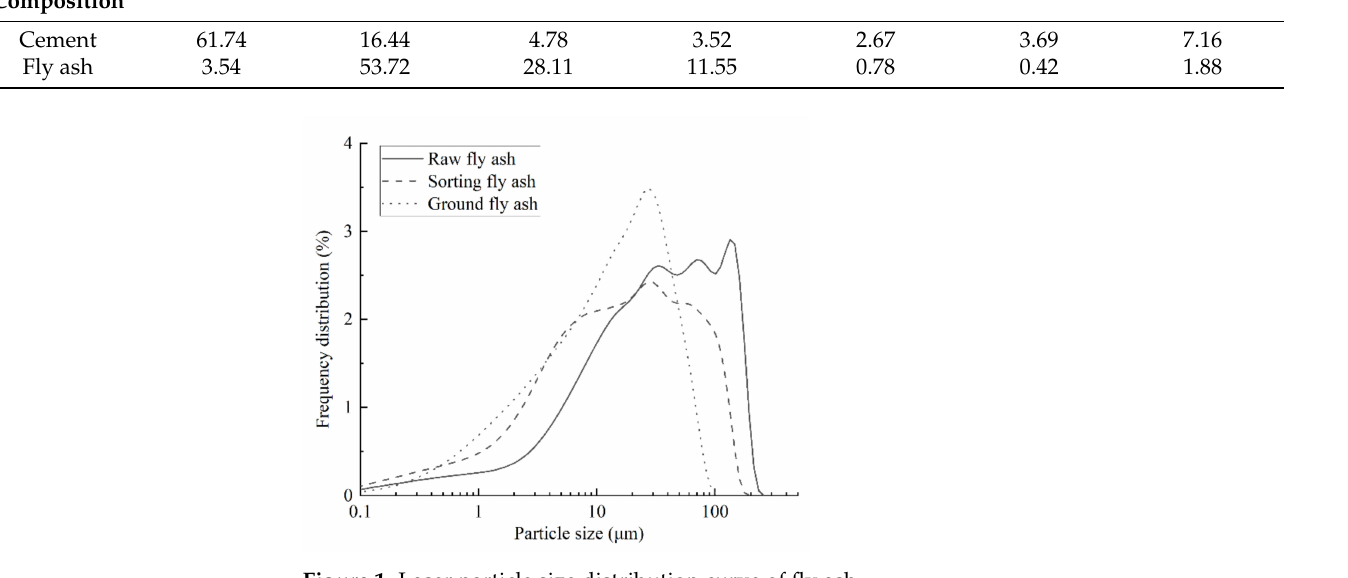
Figure 1. Laser particle size distribution curve of fly ash.